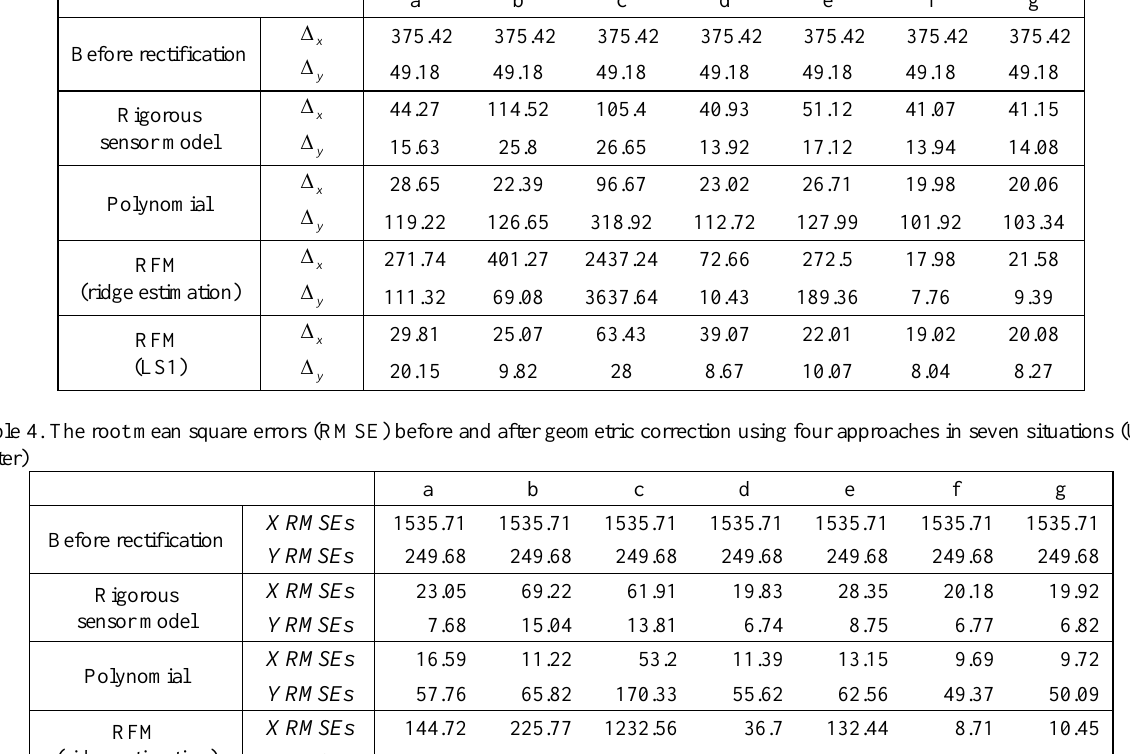
Table 3. The uncertainty intervals before and after geometric correction using four approaches in seven situations (Unit: meter) a b c d f g